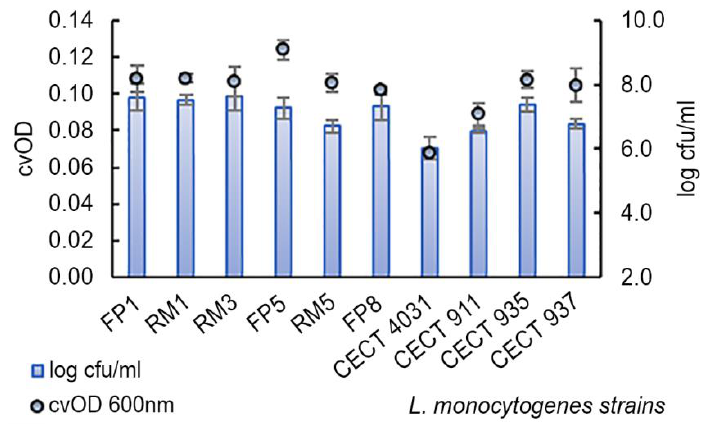
Figure 2. Average and standard deviation of log cfu / mL and cvOD of 5-day L. monocytogenes biofilms.